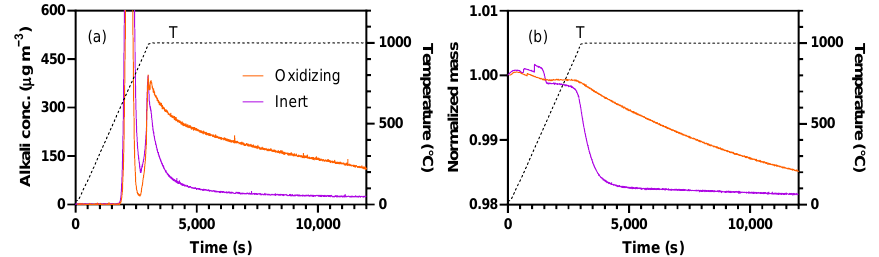
Figure 7. ( a ) The alkali desorption profiles and ( b ) mass loss profiles obtained in the experiments with an ilmenite oxygen carrier previously used for biomass combustion in a 115 MWth power plant. Experiments were carried out in inert and oxidizing atmospheres at a heating rate of 20 °C min −1 followed by an extended period at 1000 °C.